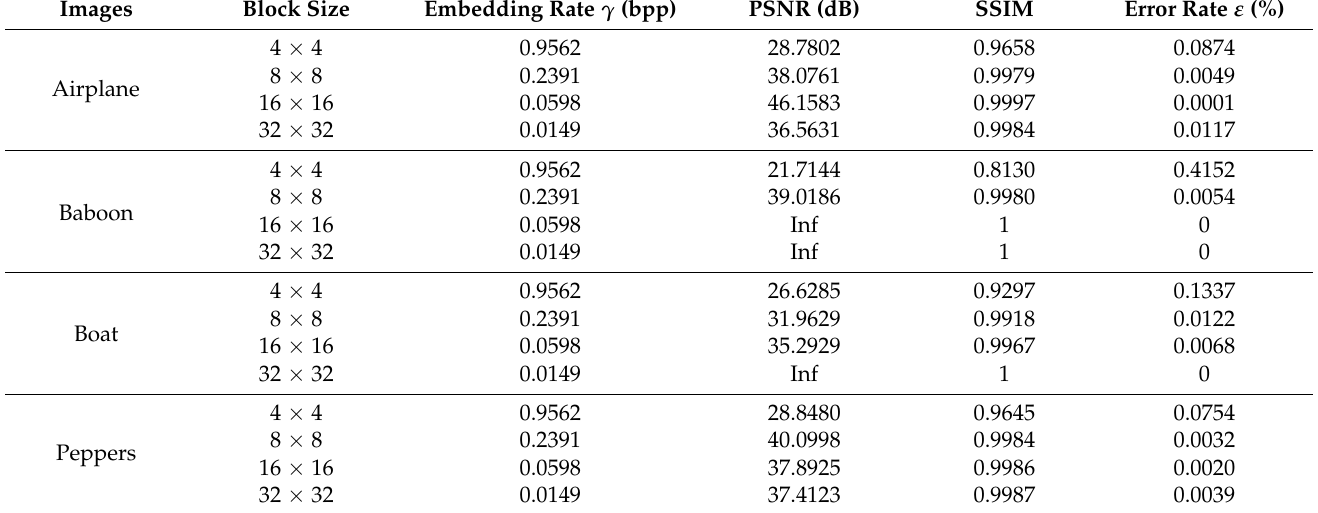
Table 4. Performances when number of sub-blocks = 8 and codebook size = 128.